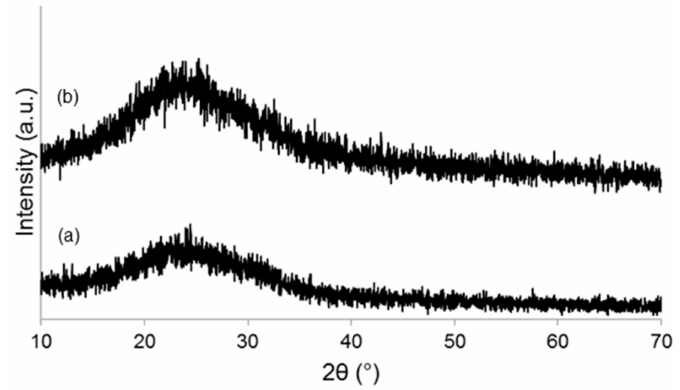
Figure 6. Wide-angle XRD pattern of ( a ) 1Cu-MBG and ( b )